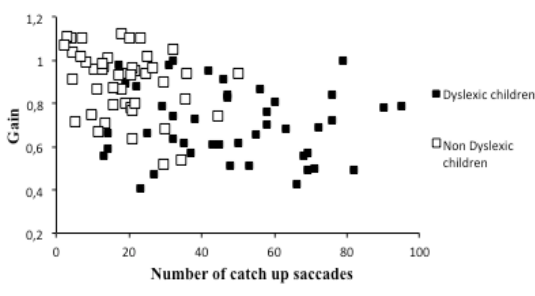
Figure 2. Gain value and the number of catch-up saccades measured for dyslexic and non-dyslexic